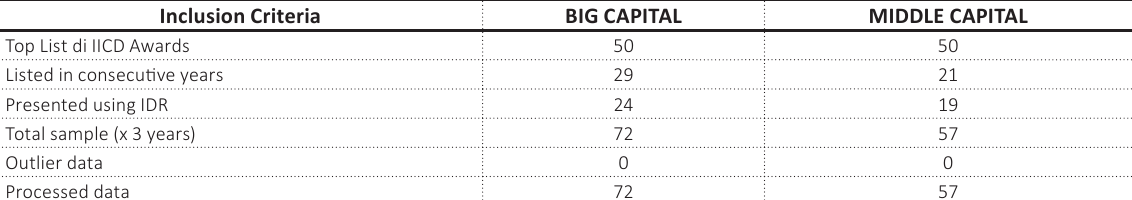
Table 1. Sampling